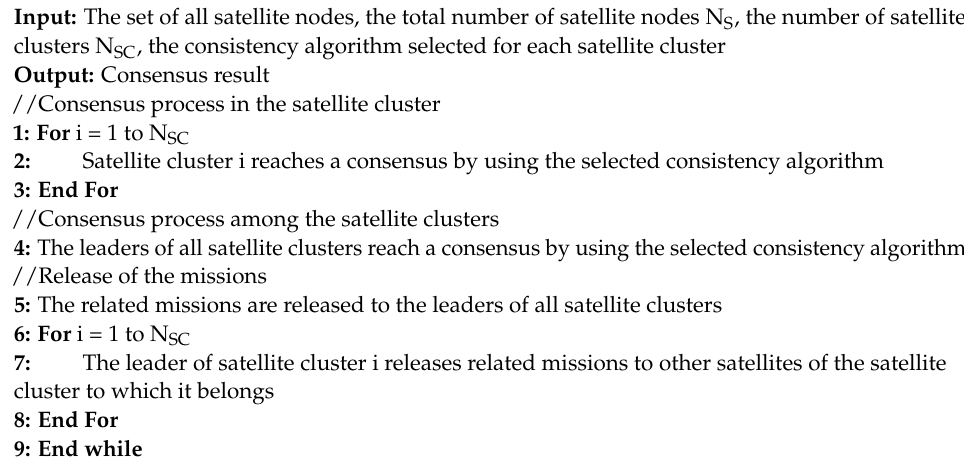
Algorithm 2. The consensus behavior of the DDPOS